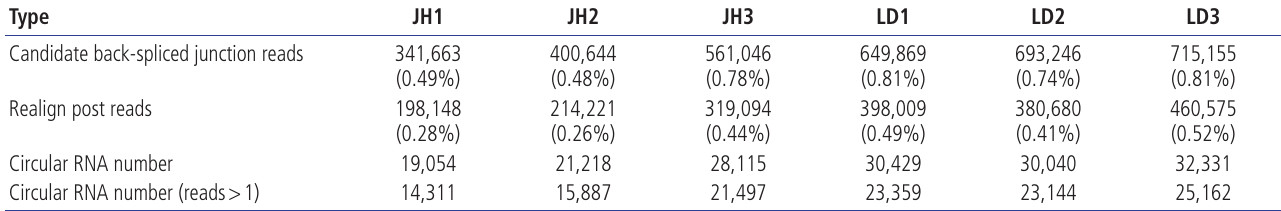
Table 2. Summary of circRNA identification result